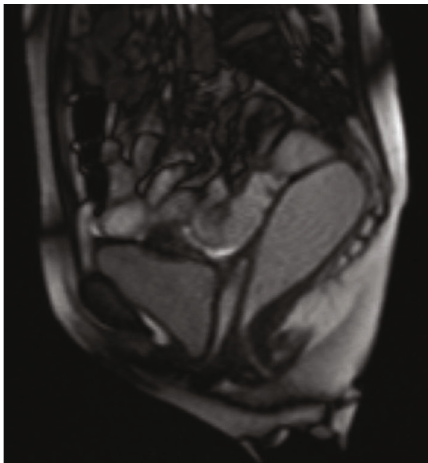
Figure 1: MRI defecography demonstrating anterior compartment prolapse. Anterior compartment descends 1.2cm below the pubococcygeal line (PCL) with defecation consistent with mild anterior prolapse.